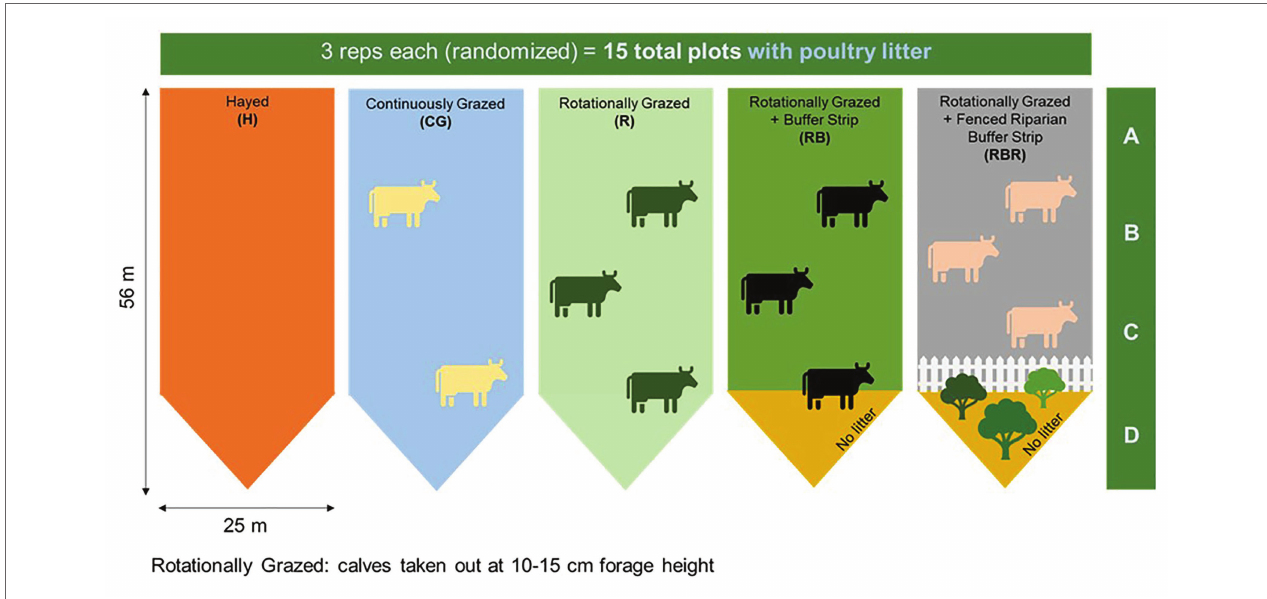
FIGURE 1 | Schematic representation of the experimental set-up. Randomized complete block design with three replications (15 watersheds total) from 2004 to 2019. All areas have received annual poultry litter applications. Figure credit: Amorim et al. (2020). Continuous treatments included: hayed (H), continuously grazed (CG), rotationally grazed (R), rotationally grazed with a buffer strip (RB), and rotationally grazed with a fenced riparian buffer (RBR). Water samples were collected from 2018–2019 at Booneville, AR. For both years, both pre and post samples were used in 16S sequencing ( n = 60 total), but only post samples were used in qPCR analyses ( n = 30 total). Therefore, only 16S methods evaluated poultry litter timing